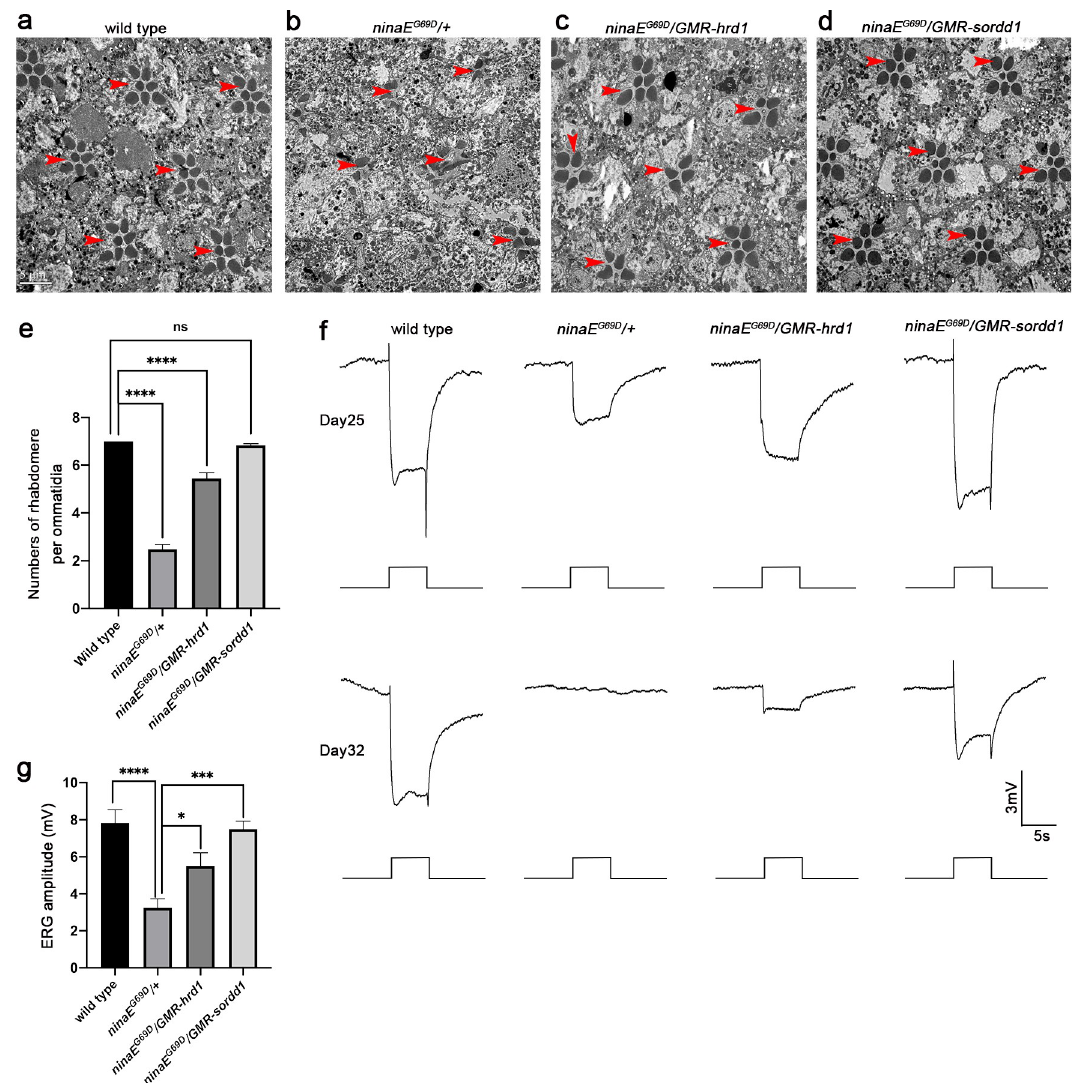
Fig 5. SORDD1 strongly suppresses retinal degeneration in the ninaE G69D model of adRP. (a-d) Representative TEM images of 25-day-old adult eye tangential sections of (a) wild type ( canton S ), (b) ninaE G69D /+ , (c) ninaE G69D /GMR-hrd1 and (d) ninaE G69D / GMR-sordd1 flies. Rhabdomeres are indicated by red arrows. Scale bar, 5 μ m. (e) Quantification of a-d , Error bars indicate SEM; sections from three individual flies of each genotype were used for quantification. ns, not significant, ���� p < 0.0001 (one-way ANOVA, Sidak’s multiple comparisons test). (f) ERG recordings of 25-day-old and 32-day-old wild-type, ninaE G69D /+ , ninaE G69D / GMR-hrd1 and ninaE G69D /GMR-sordd1 flies. Flies were exposed to a 5-s pulse of orange light after 1 min of dark adaptation. (g) Statistic results of the amplitude of ERG recordings of flies at age of 25 days, Error bars indicate SEM; n = 6, � p < 0.1, ��� p < 0.001, ���� p < 0.0001 (one-way ANOVA, Sidak’s multiple comparisons test). Red-eyed flies were raised under constant light conditions. All flies were in w + background and were raised in 24 h constant light (~700 Lux) at 25˚C. two independent ER enzymes, HRD1 and SORDD1/2. The ubiquitylated protein is then trans- ported out of the ER membrane via the VCP complex and degradation in cytosolic protea- somes. Although HRD1 also functions (in complex with HRD3) as a retro-translocation channel to facilitate removal of substrates from the ER [29, 30], HRD1 and HRD3 are dispens- able for SORDD1-mediated degradation of Rh1 G69D ; thus, SORDD1 suppresses Rh1 G69D - induced ER stress and cell damage independent of HRD1 and HRD3. Although we